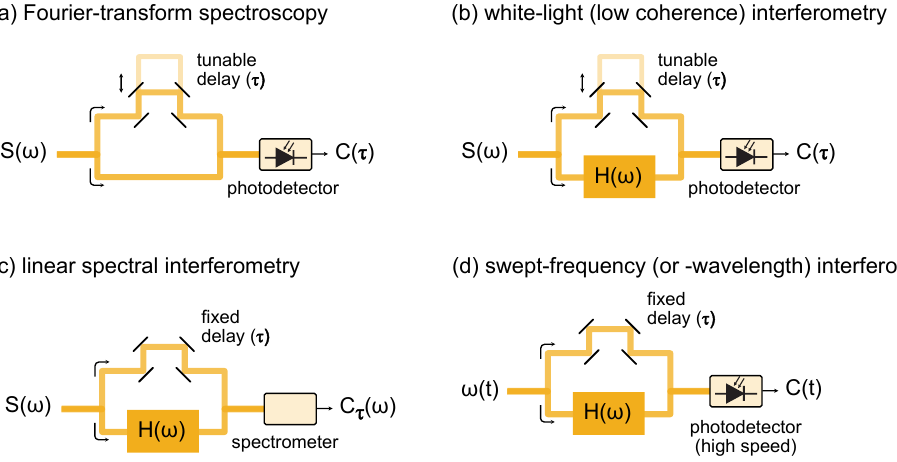
Figure 1. Simplified schemes for Fourier transform spectroscopy and spectral interferometry with broadband light sources. ( a ) Fourier transform spectroscopy; ( b ) low coherence (or white light) interferometry; ( c ) linear spectral interferometry and ( d ) swept frequency interferometry. In Fourier transform spectroscopy ( a ), an interferogram is recorded as a function of the relative delay